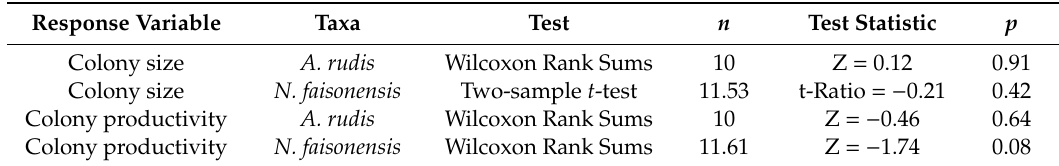
Figure 2. Mean ( a ) colony size (number of workers) and ( b ) colony productivity (number of broods / number of workers) of non-dominant ant species A. rudis and N. faisonensis near and far from focal nests of dominant F. subsericea . Asterisks indicate significant di ff erences ( p < 0.05). Table 3. Variation in colony size and productivity of colonies of non-dominant ant species (Ar and Pf) near and far from F. subsericea